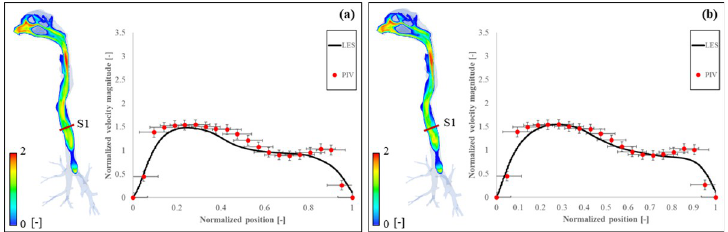
Fig 10. Airflow distribution and PIV comparison for (a) cell size � 0.40 mm and (b) cell size = 0.20 mm in the respiratory tract.